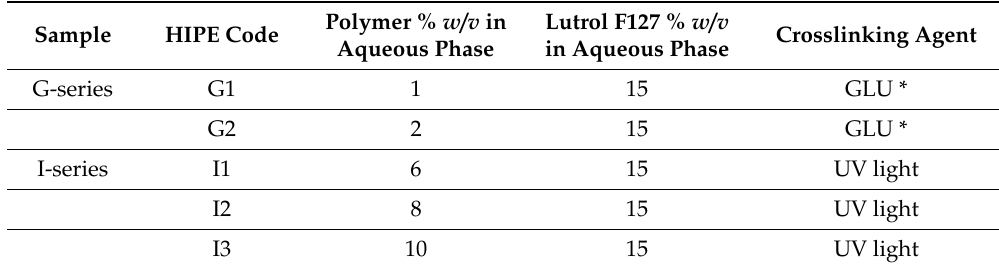
Table 2. HIPE compositions with water as the aqueous phase, isopropyl myristate as the oil phase, and with an oil / water ratio of 80% v / v